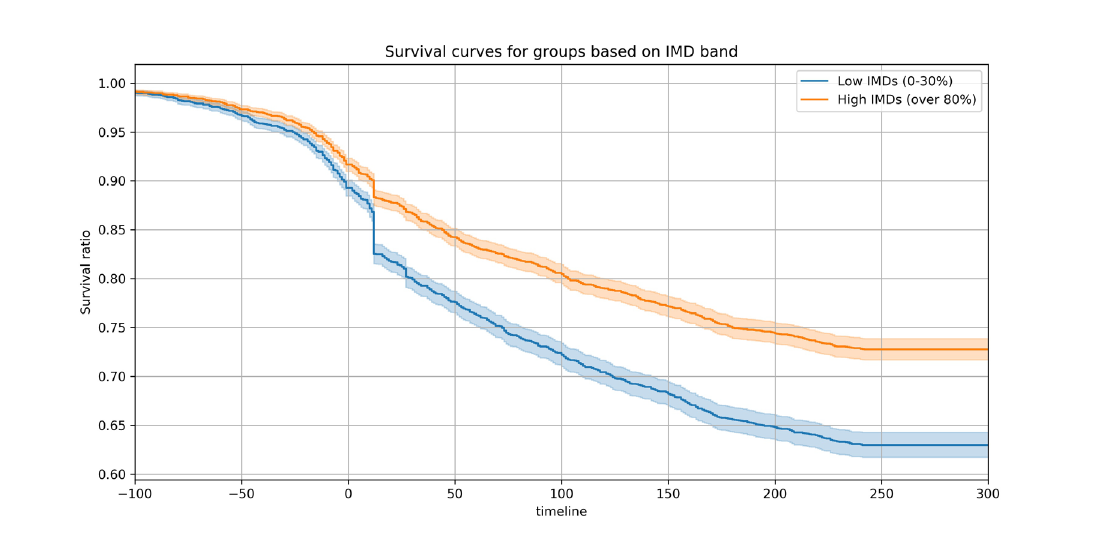
Note . Top panel: The survival curve for gender. Bottom panel: The survival curve for IMD band. IMD = index of multiple deprivation.